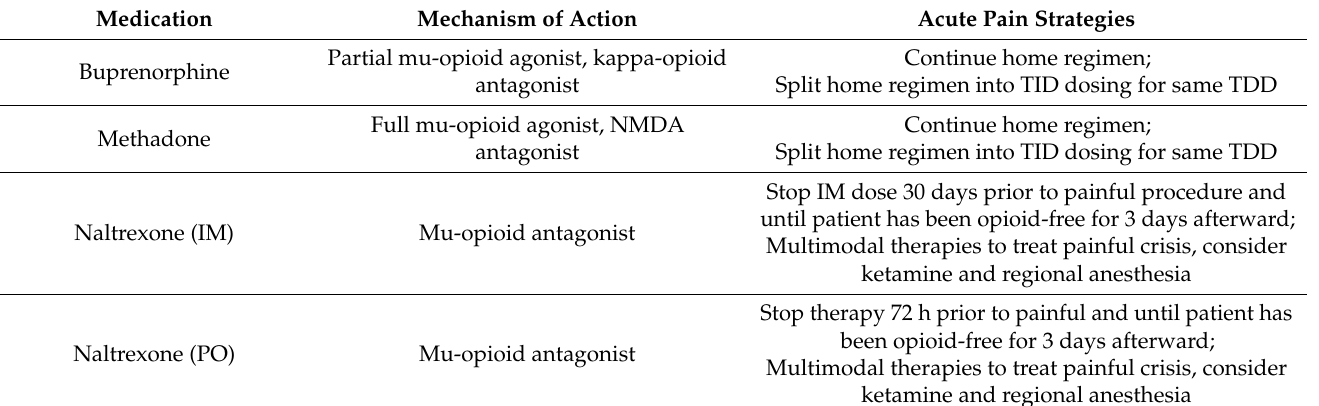
Table 5. Management of MOUD during acute painful